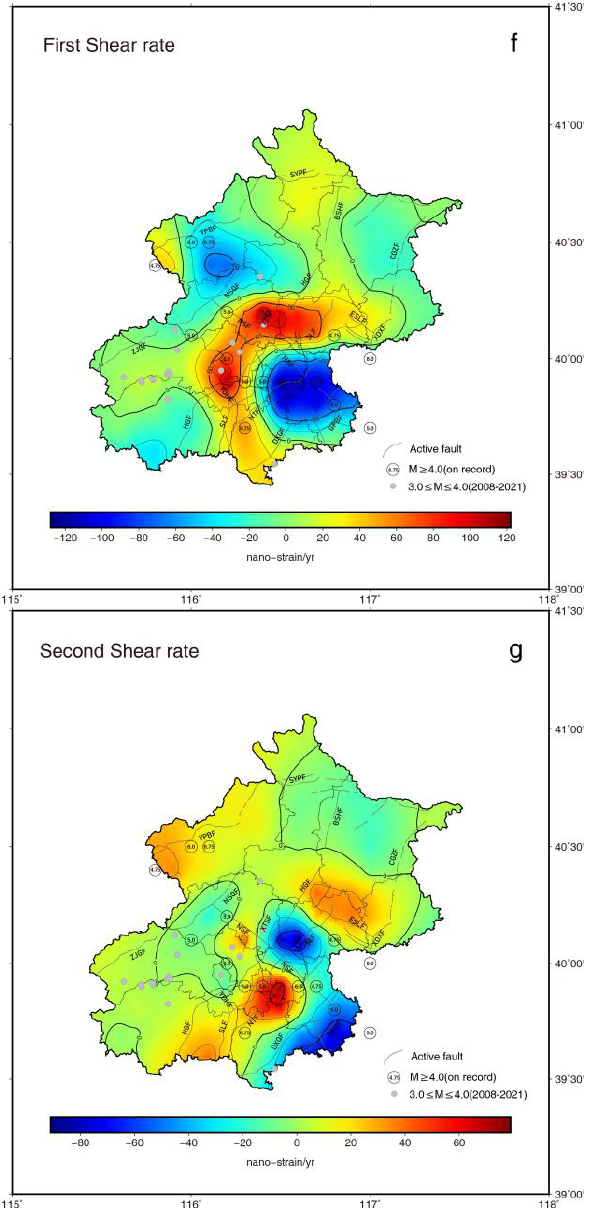
Figure 4. Continuum deformation field of Beijing area derived from interpolation of GNSS velocities. (a) Strain rates. Dilatation strain rate is shown in background color and principal strain rates are shown as vector pairs. (b) Maximum strain rate. (c) Rotation rate, with counterclockwise rotation positive. (d) East-West rate. (e) North-South rate. (f) First shear strain rate. (g) Second shear strain rate. The gray solid line shows the active faults, and the fault name abbreviations are consistent with those in Figure 1. The gray dots reprensent the earthquake of M3.0~4.0 occurred between 2008 to 2021. The large hollow circles are the earthquake greater than M4.0 that have occurred on record, the number indicates the magnitude of the